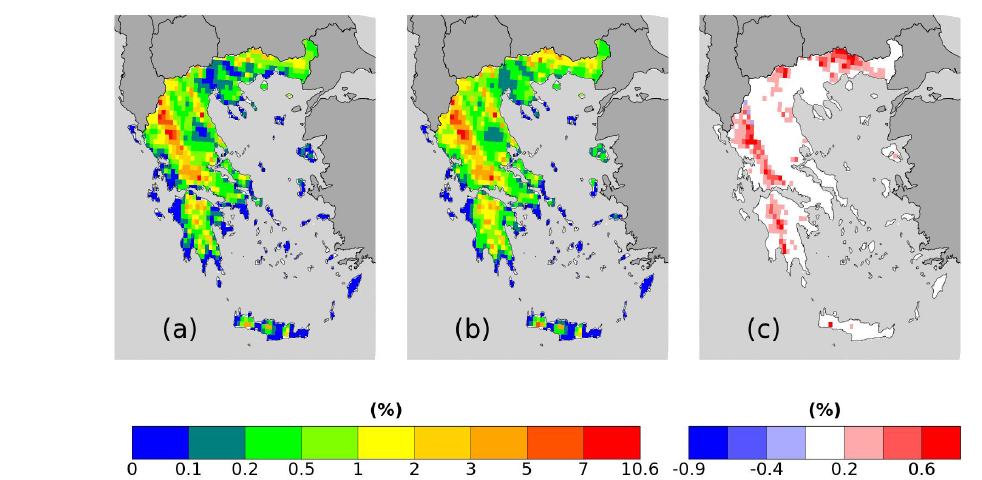
Figure 8. RR20FD ensemble probabilities for (a) empirical and (b) copula method. (c) = (b) – (a) .